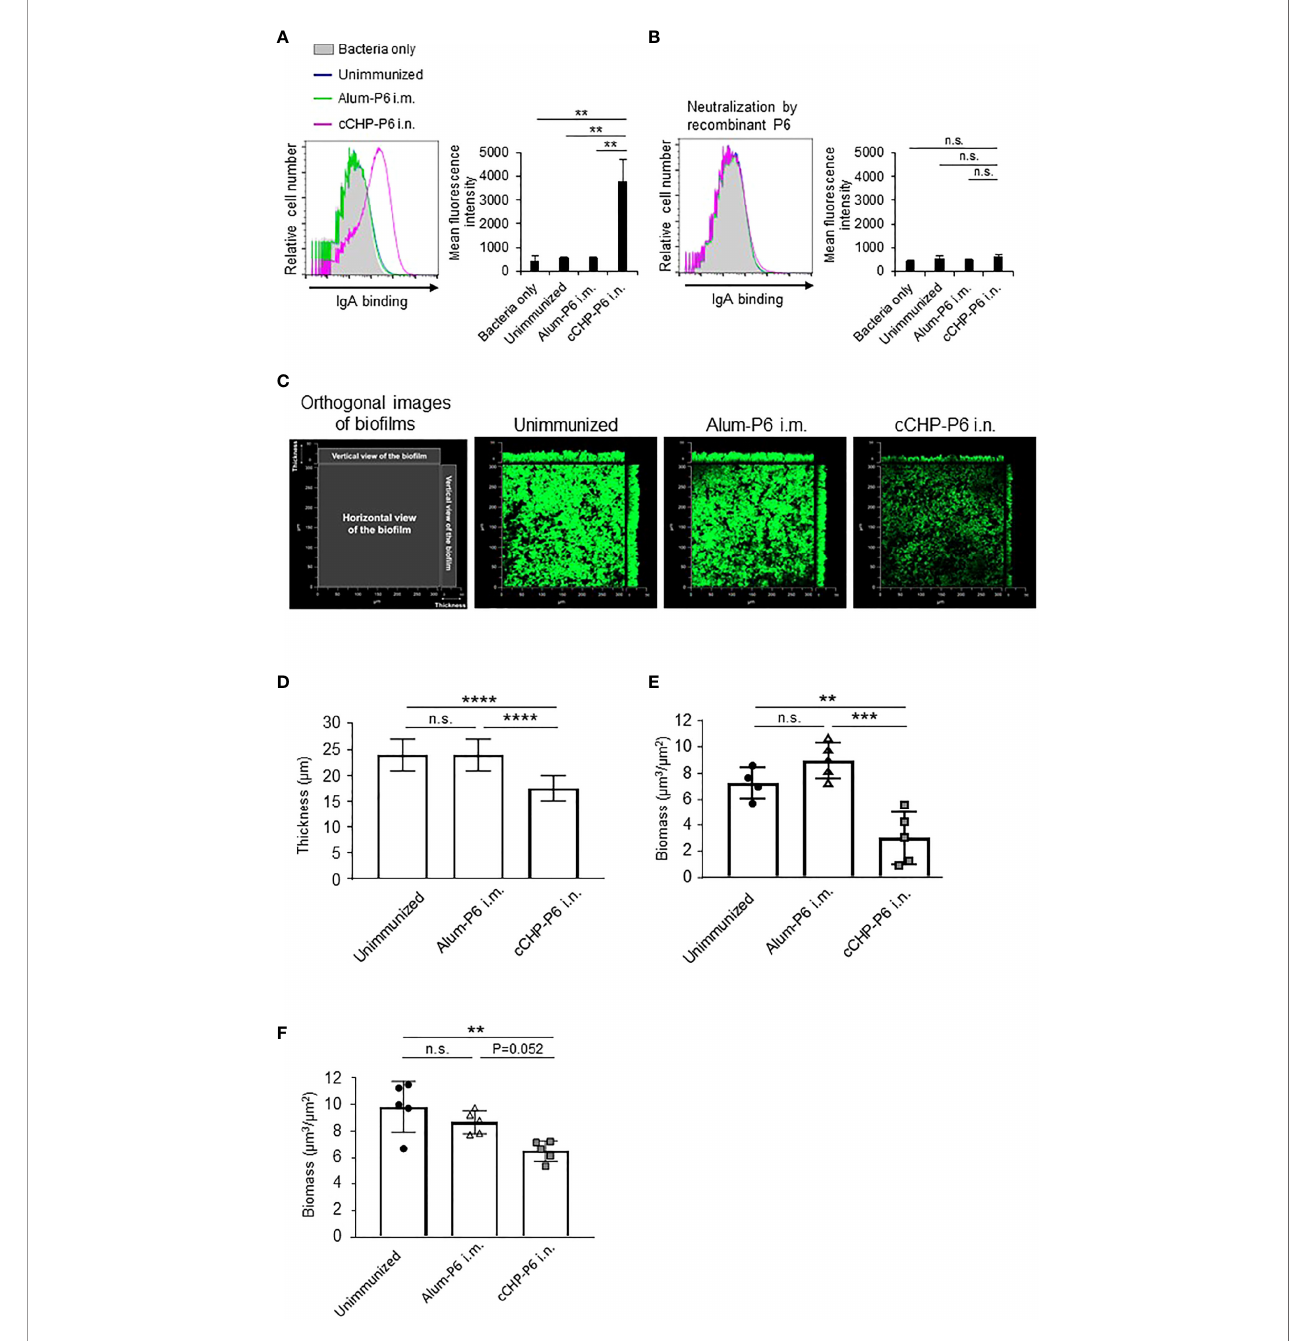
FIGURE 2 | P6-speci fi c IgA directly binds to NTHi and inhibits bio fi lm formation. (A, B) The binding activity of P6-speci fi c IgA in nasal washes on the surface of NTHi strain 76 (A) or its activity after P6 protein neutralization (B) was determined by FACS analysis. The mean fl uorescence intensity indicates antibody binding. (C) NTHi bio fi lms grown at 37°C, 5% CO 2 for 40 h in a glass chamber slide with nasal washes of unimmunized or immunized mice. Bio fi lms were visualized with LIVE/DEAD BacLight viability stain and imaged with a confocal laser scanning microscope. (D – F) Bio fi lm thickness (D) and biomass values (E) treated with nasal washes or (F) biomass values treated with IgG-depleted nasal washes were quanti fi ed by using COMSTAT2 software. Data are representative of three independent experiments. ** P < 0.01; *** P < 0.005; **** P < 0.001; n.s., not signi fi cant; one-way ANOVA with post-hoc Tukey test. Values are means ± 1